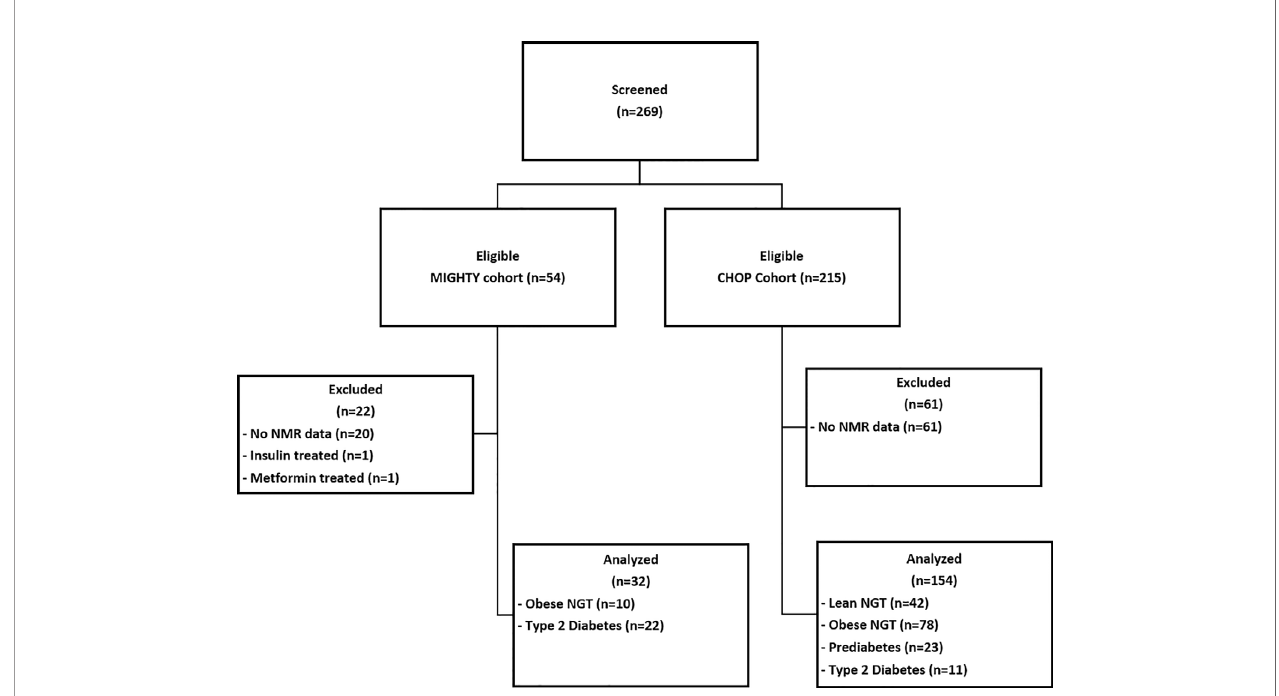
FIGURE 1 | Participant Flow Diagram. MIGHTY, Metformin In fl uences Gut Hormone Study in Type 2 Diabetes Youth; CHOP, Children ’ s Hospital of Philadelphia; NMR, nuclear magnetic resonance; NGT, normal glucose tolerant; PreDM, prediabetes; T2DM, type 2